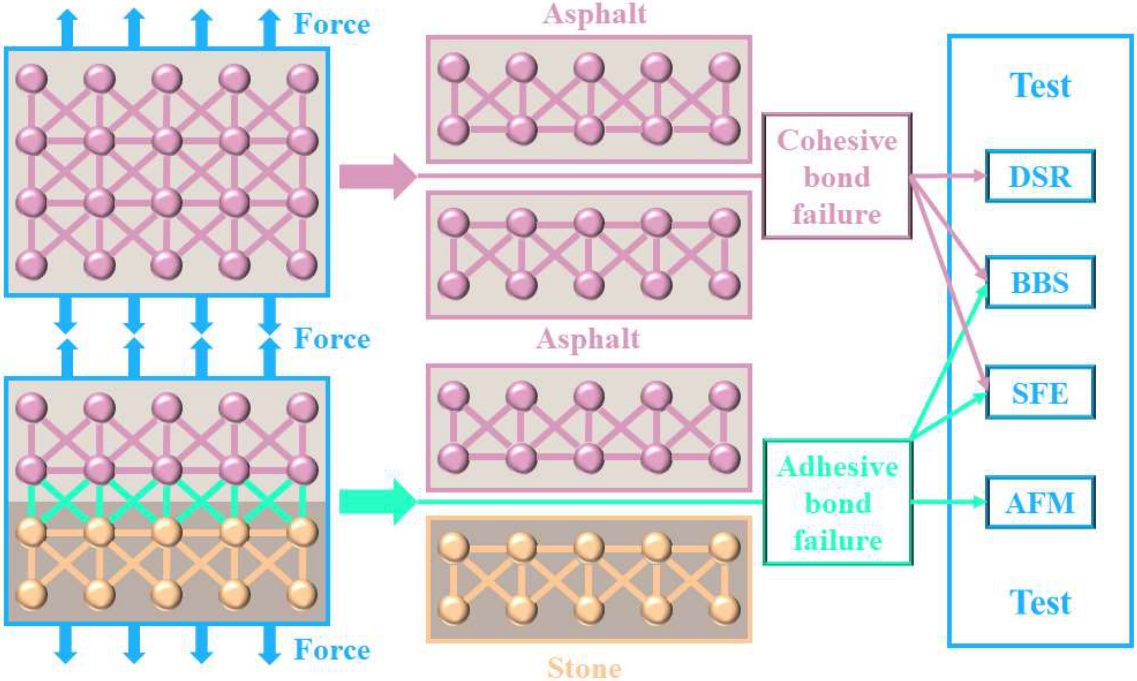
Figure 4. Cohesive and adhesive bond failure.